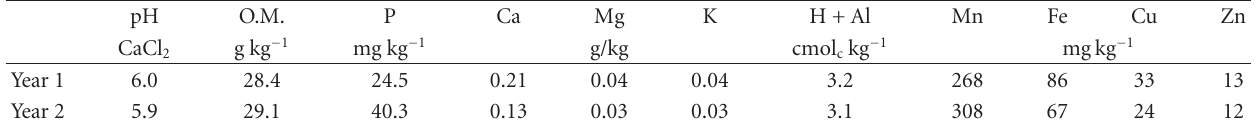
Table 1: Study site soil chemical characteristics (0–10cm layer) at Rolandia County, Parana State, Brazil.